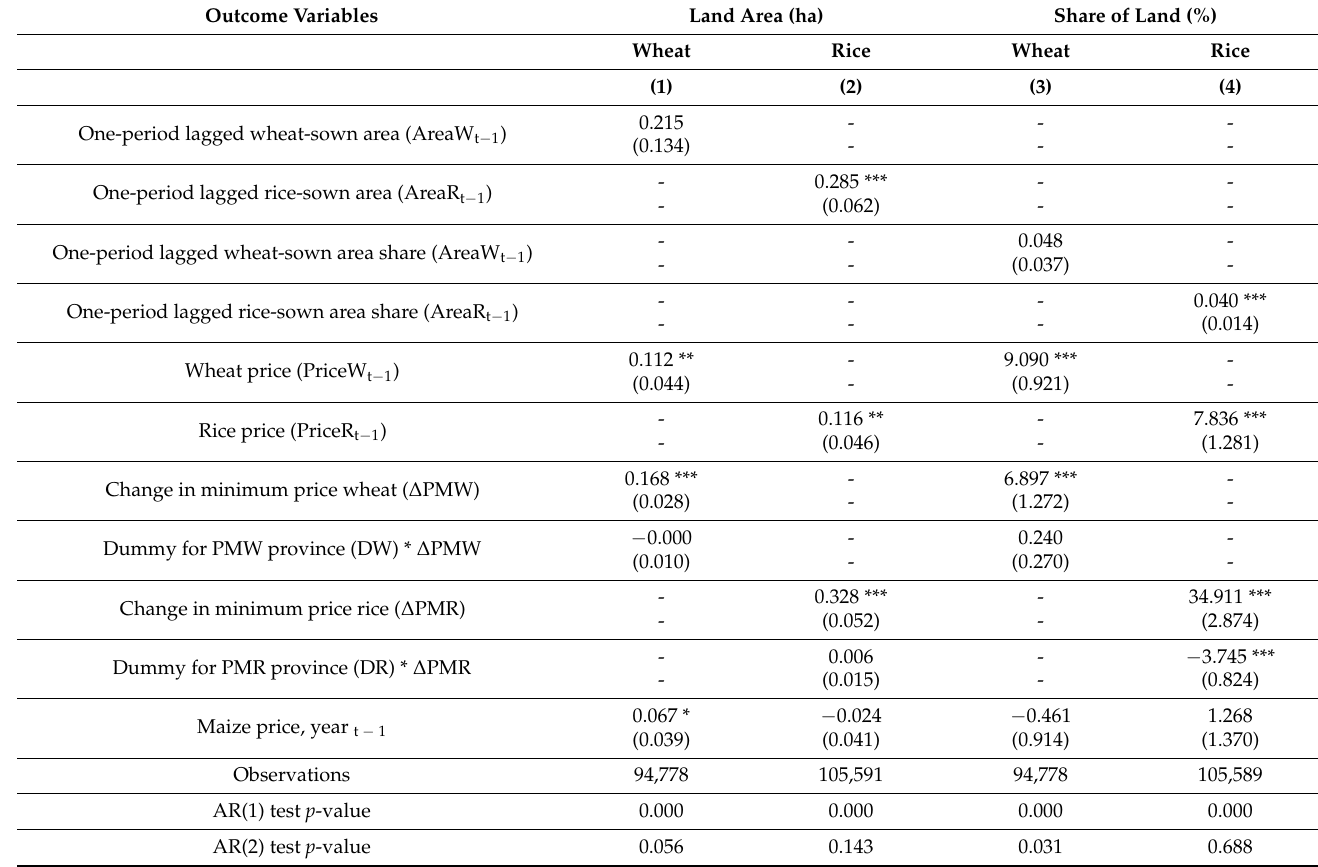
Table 4. Difference generalized methods of moments (GMM) regression results for sown land